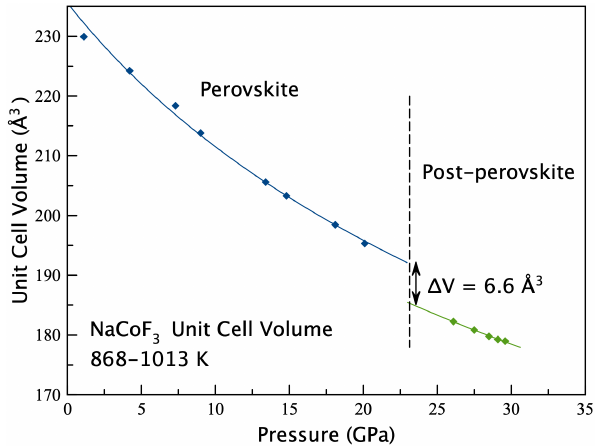
Figure 4. Normalized stress t/G in NaCoF 3 perovskite (green cir- cles) and post-perovskite (blue diamonds) as a function of pressure. The solid line is a visual guide through the experimental data. The perovskite to post-perovskite transition occurs between 20.1 and